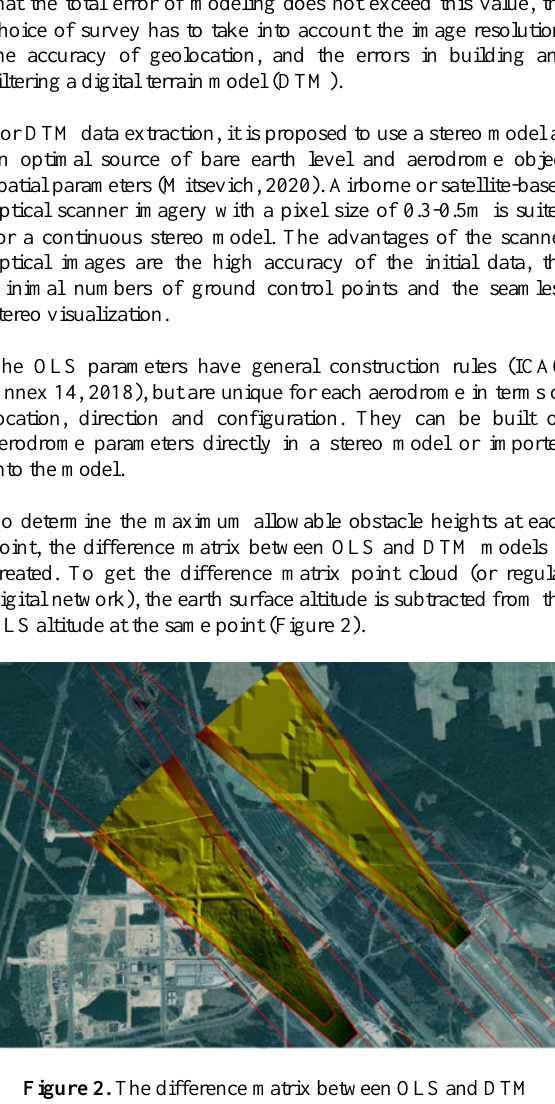
Figure 2. The difference matrix between OLS and DTM To clarify the visualization, isolines with equal heights are drawn on the difference matrix with a given step that does not exceed the vertical accuracy of obstacle determining (Figure 3).